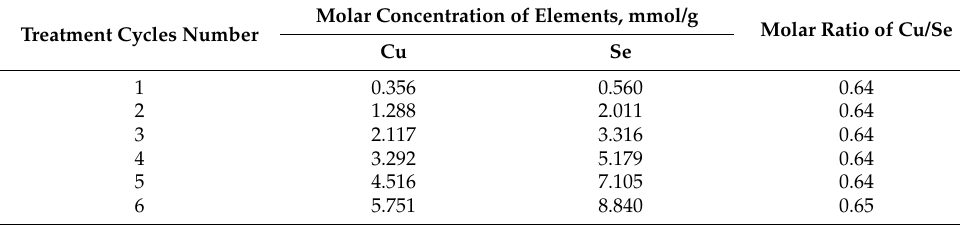
Table 3. Bulk elemental contents of copper and selenium in Cu x Se coating on wool fibers. Molar Concentration of Elements, Treatment Cycles Number